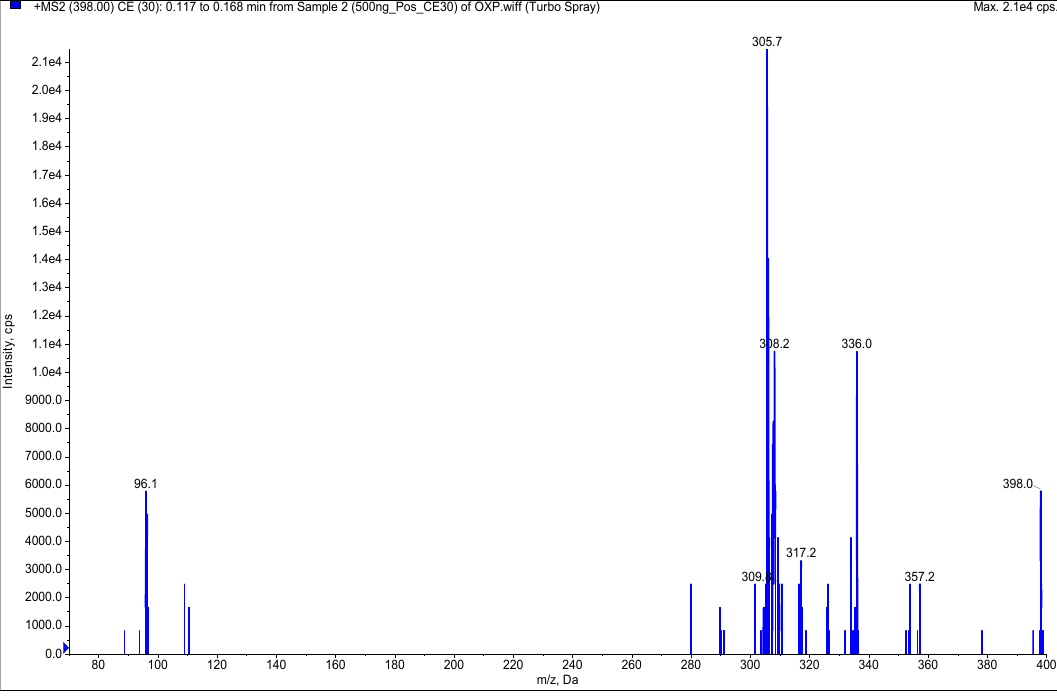
Figure 2. Product ion mass spectra of OXP ( m/z : 398.06 306.00).